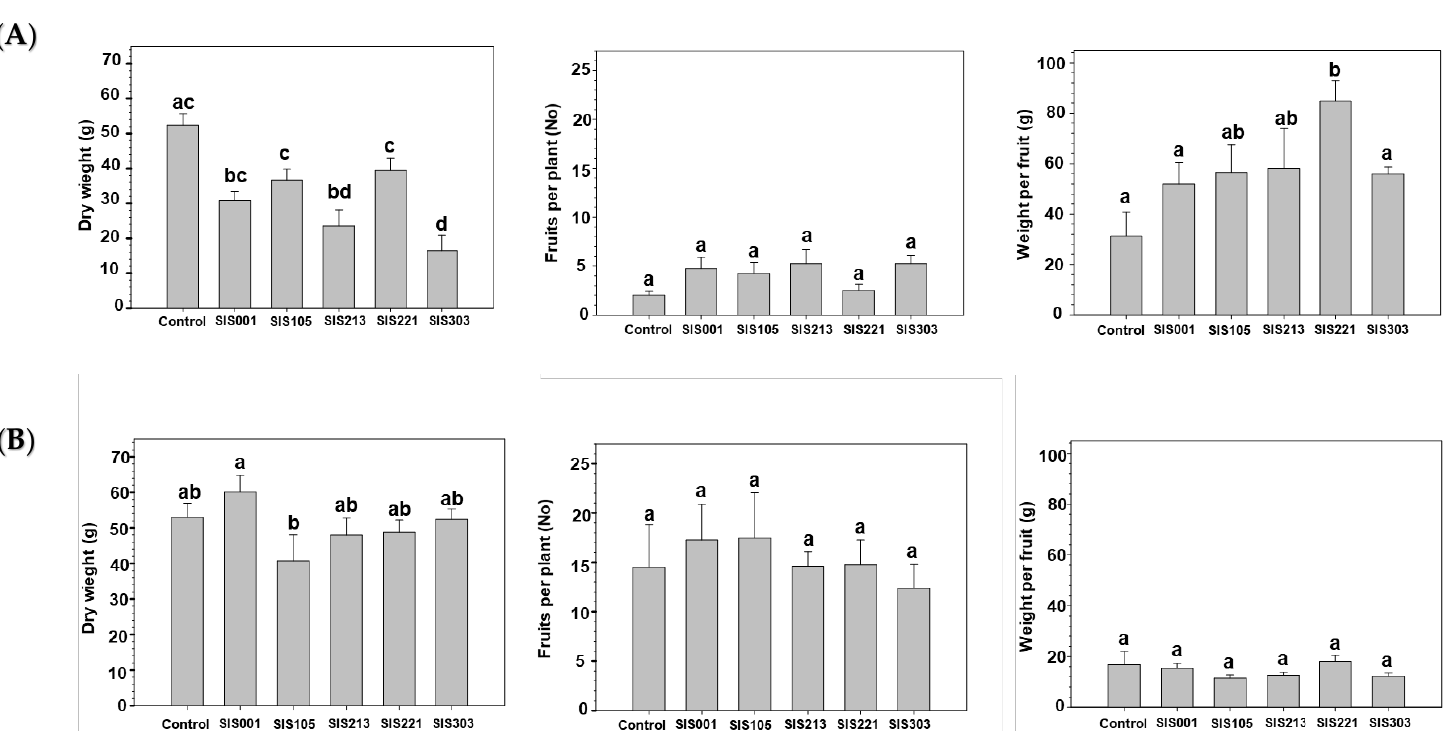
Figure 1. Effect of rhizobacteria inoculation on biometry of ( A ) Tres Cantos and ( B ) cherry plants. Data are the means ± SE of 3 replicates. Values marked with different letters within each panel are significantly different according to Duncan’s multiple range test, p < 0.05. Treated plants were harvested 4 months after inoculation of rhizobacteria, and the dry weight of the shoot ( left ), number of fruits per plant ( middle ) and weight of every fruit ( right ) was measured.